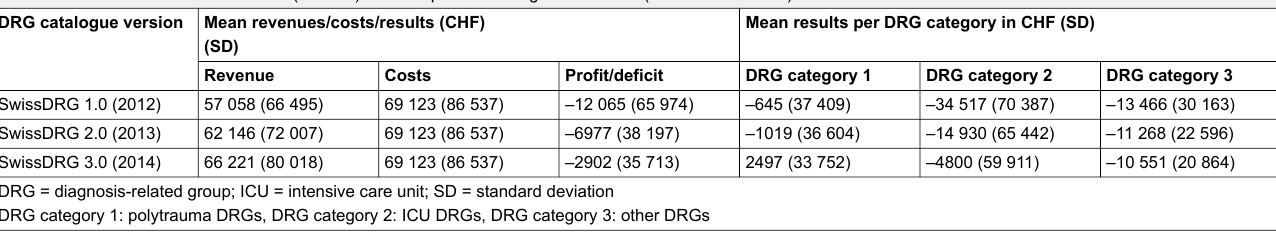
Table 3: Average results per case according to SwissDRG versions 1.0, 2.0 and 3.0, including supplementary payments, for study group and different DRG categories. A base rate of 11300 CHF was assumed (n = 364). Results per case are given as mean (standard deviation).